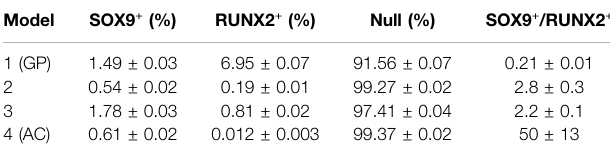
TABLE2| DistributionofECHOcellfatesfrom1,000,000randominitializationsfor each model. Errors give the boundaries of 99% con fi dence intervals.